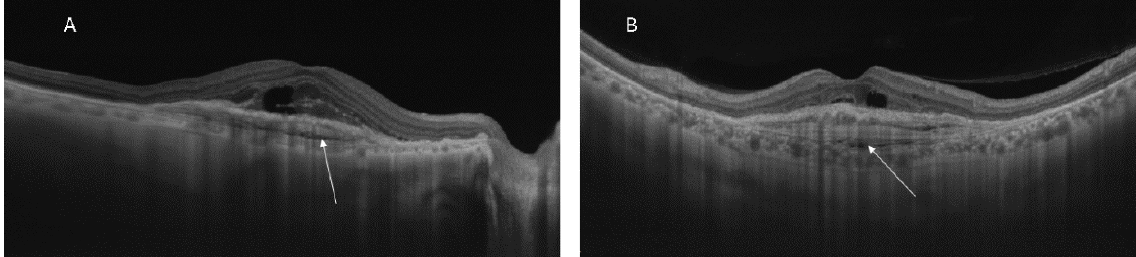
Figure 4: The radial scans of the SSOCT of the right eye (A) and the left eye (B) show the spindle-shaped horizontal laminae in the area of the PED that are characteristic of a multilayered PED along with the hyporeflective choroidal cleft (arrows). Both eyes show some amount of subretinal fluid after 6 anti-VEGF injections in the right eye and 8 in the left